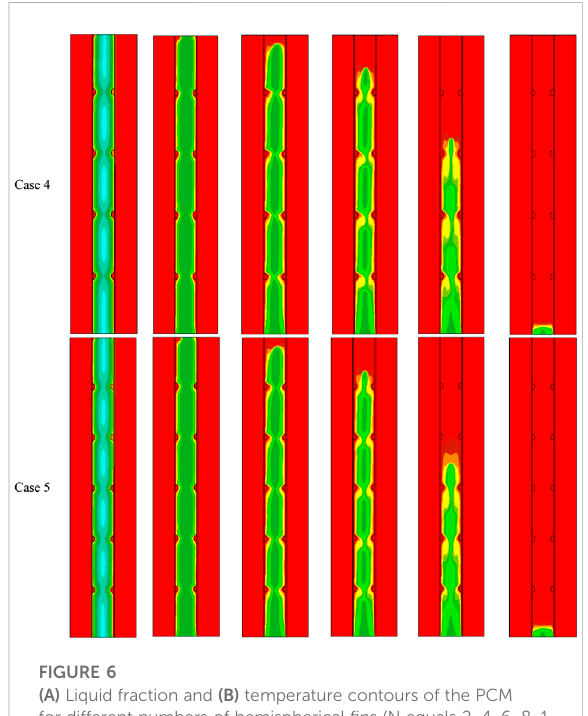
FIGURE 6 (A) Liquid fraction and (B) temperature contours of the PCM for different numbers of hemispherical fi ns (N equals 2, 4, 6, 8, 1, and 10) at various time